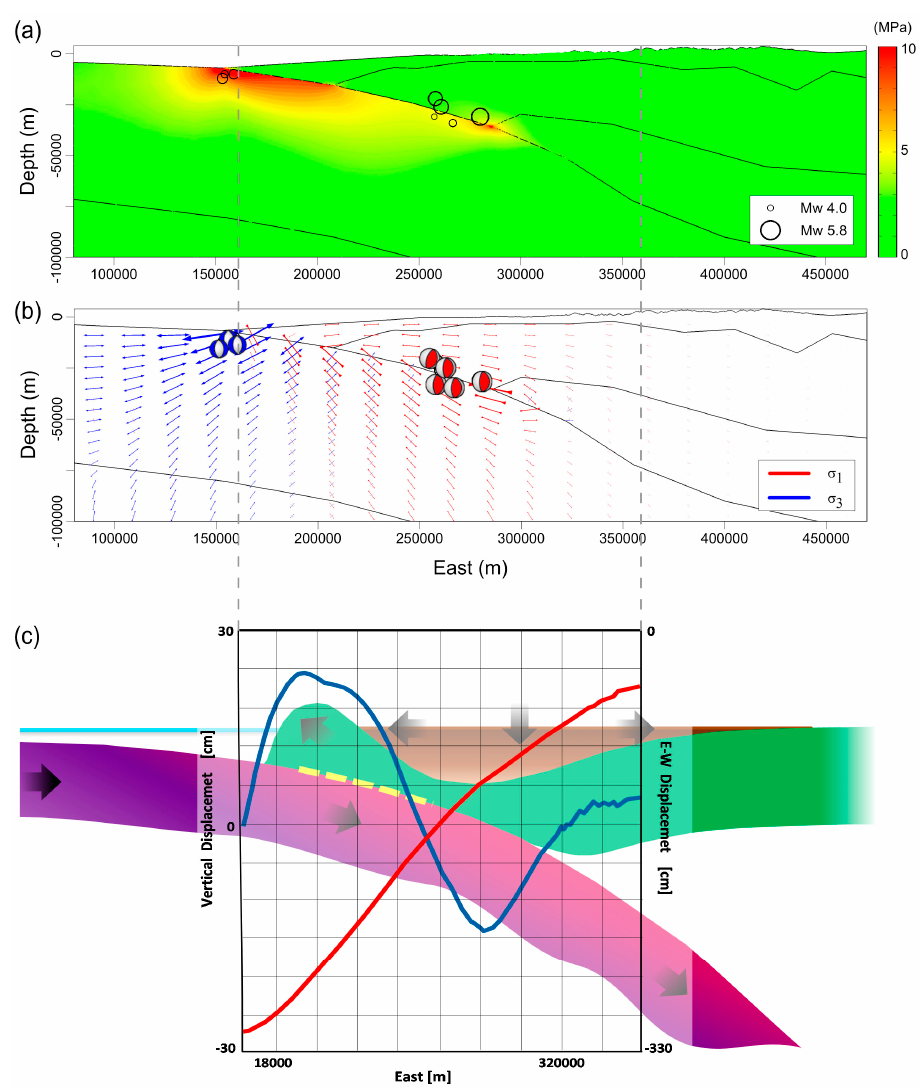
Figure 6. Stress distribution analysis inferred from the FE modeling. ( a ) Von Mises distribution. One month of aftershocks (with M > 4.3), located within 10 km north and south from the AA’ profile (see Figure 3 for AA’ trace profile) and recorded by the GEOFON network, is reported. ( b ) Principal stress orientation. ( c ) Conceptual model, modified after [21], on the kinematics of the megathrust faulting inferred from our modeling results, with the indication of the vertical (blue curve) and EW (red curve) DInSAR displacement along a portion of the subduction zone highlighted by the grey dashed lines.